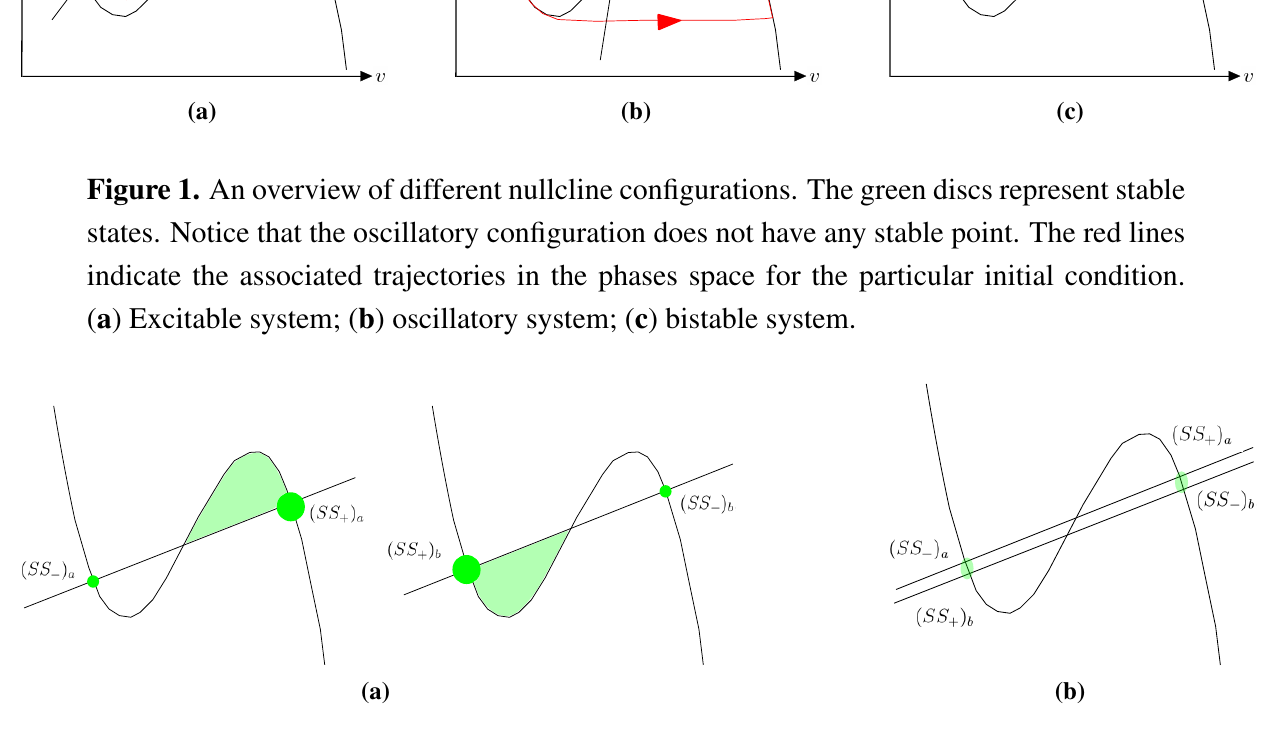
Figure 2. Asymmetric nullcline configurations for a bistable system. The green discs represent stable states. In a spatially extended system, the stable states drive the system to spatially distributed steady states. ( a ) Two possible asymmetric configurations for a bistable system; ( b ) Superposition of both asymmetric